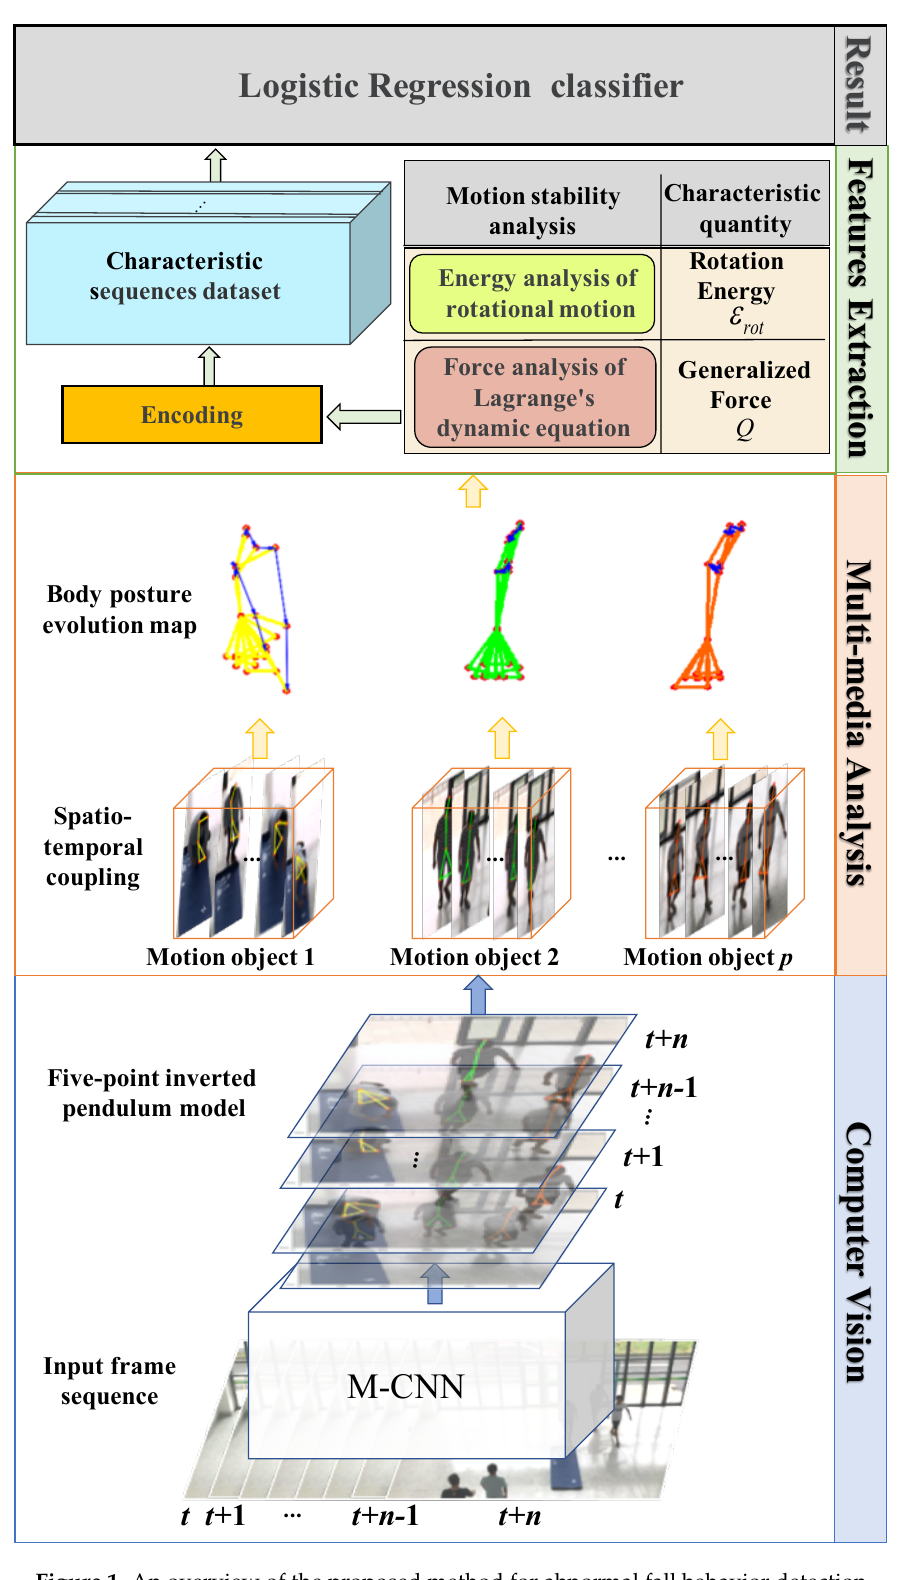
Figure 1. An overview of the proposed method for abnormal fall behavior